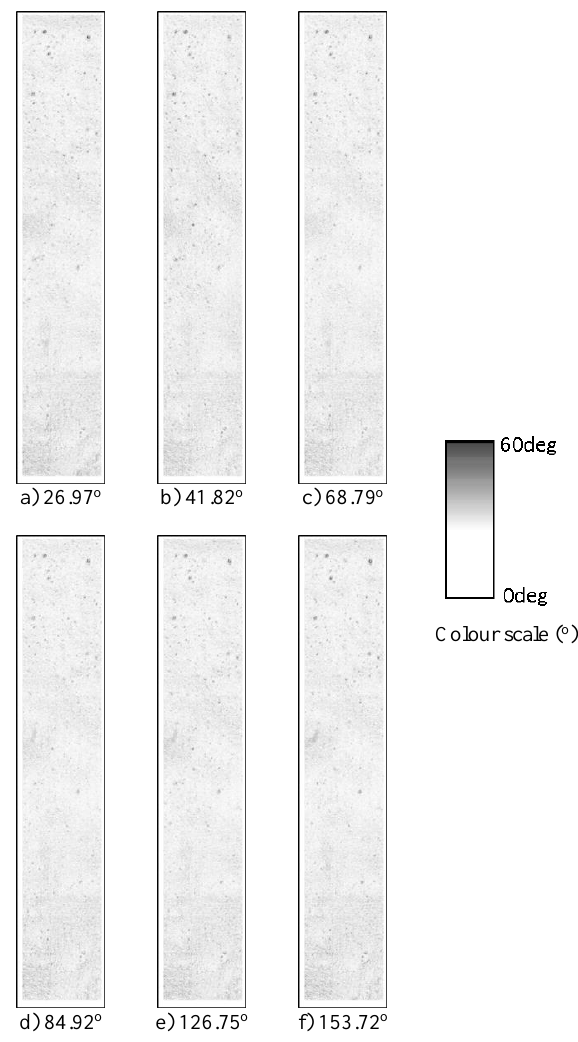
Figure 4. Angular difference DEMs (1m/pixel) at each illumination azimuthal difference